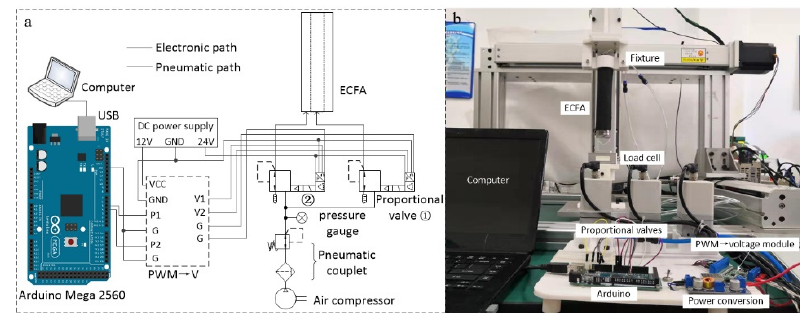
Figure 6. Experiment setup. ( a ) Schematic diagram of electronic path and pneumatic path. ( b ) Physical diagram.